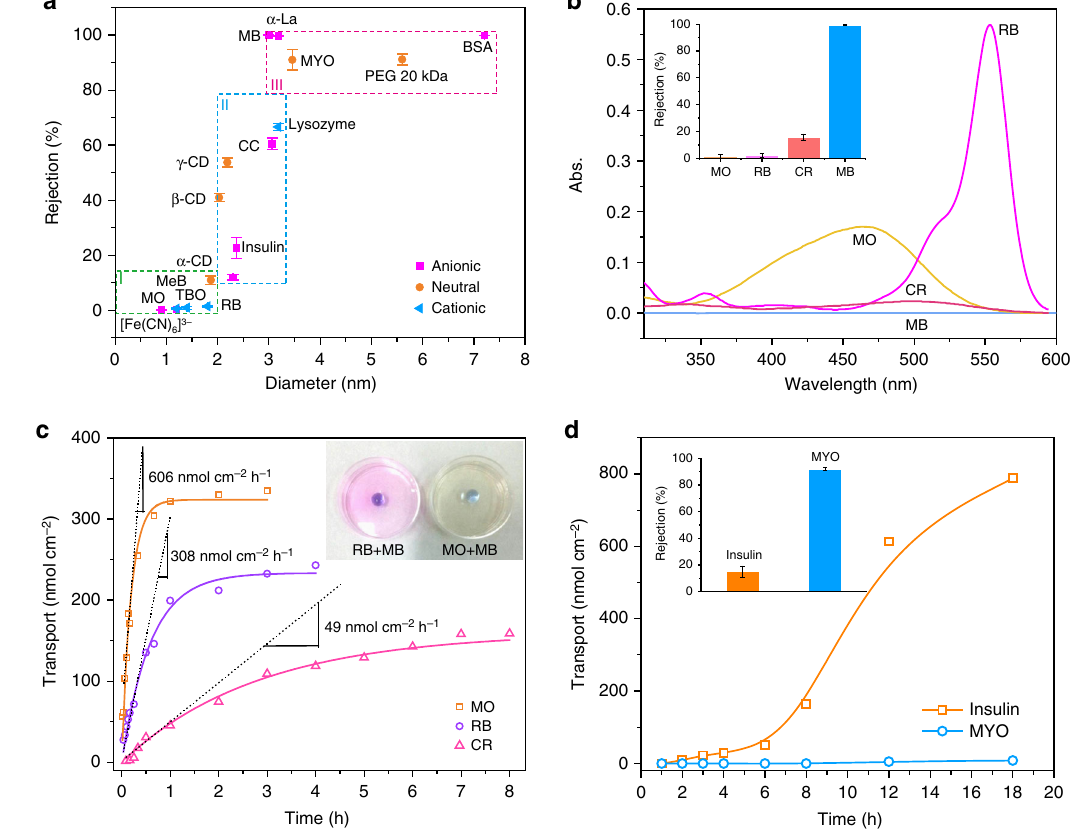
Fig. 3 The separation performance of the cross-linked PTL membranes. a Separation performance of the 50-nm-thick PTL membranes for neutral and ionic compounds including region I, <10% rejection of molecules with diameters <2.0nm; region II, 20 – 80% rejection of molecules with diameters of 2 – 3 nm; and region III, >90% rejection of molecules larger than 3 nm in diameter. b UV-vis spectra of the water side below the membrane after 12 h of permeation by using different dyes as the feed solution and the corresponding rejection ratios (inset). c Time-dependent transport of dyes through the PTL membrane and the transport rate calculated as the initial slope of the transport curve 7,38 . Optical photographs to show how the membrane rejects large molecules (methyl blue, MB) while allowing small molecules (methyl orange, MO and rhodamine B, RB) to pass through. d Time-dependent transport of proteins through the PTL membrane and the rejection ratios of MYO and insulin from the mixture (inset). The initial concentration of the protein solution is 10 mg mL − 1 . Data shown are the average of triplicates with standard